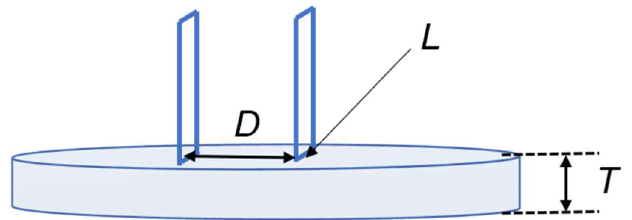
Figure 1. Schematic view of the two-electrodes